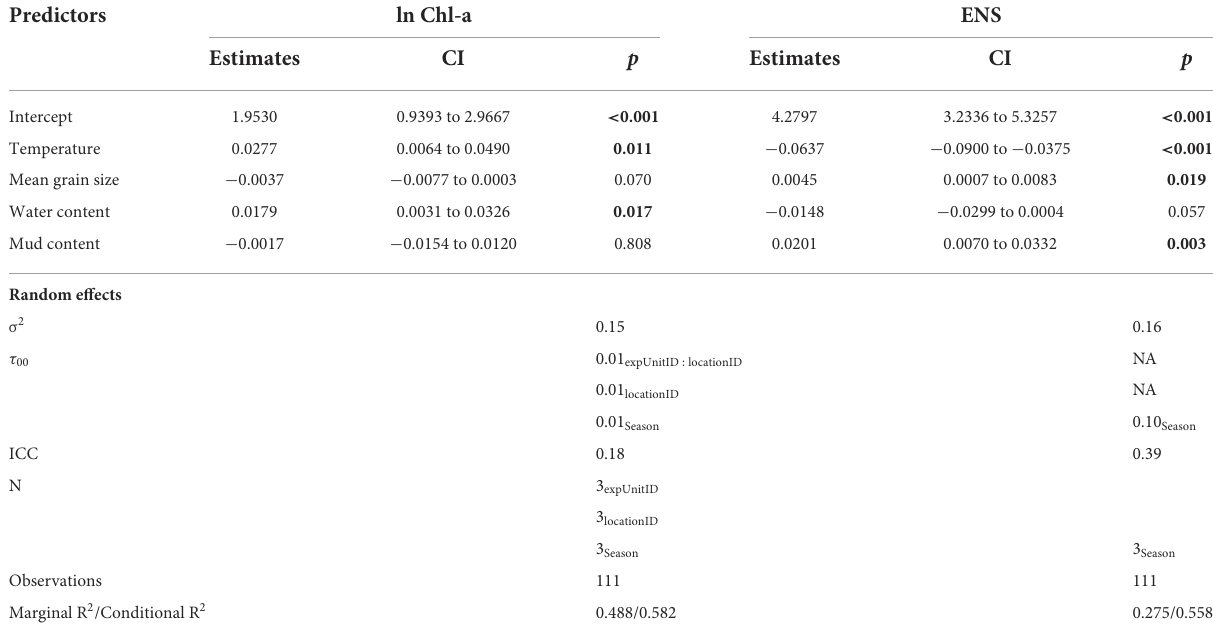
TABLE 2 Linear mixed effects model output from the analysis of the response variables chlorophyll-a and pigment diversity (ENS) against the predictor variables: temperature, mean grain size, water content, and mud content on natural transects.